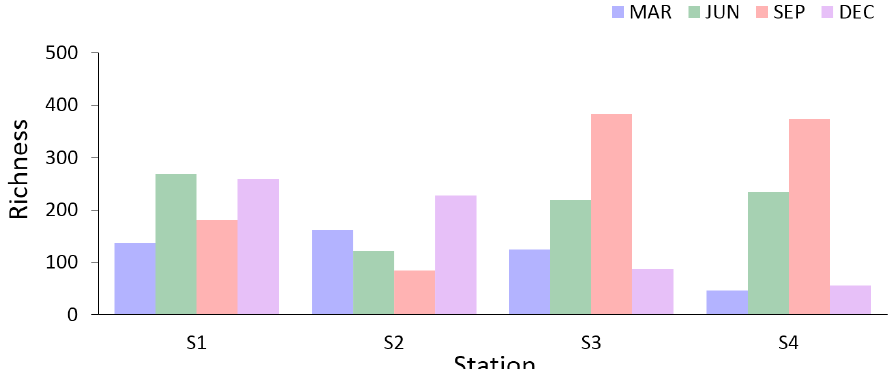
Figure 5. Richness of ciliate communities in different seasons in four sampling stations (S1–S4). Histogram shows Simpson index, with error bars showing standard error of the mean. DEC, December